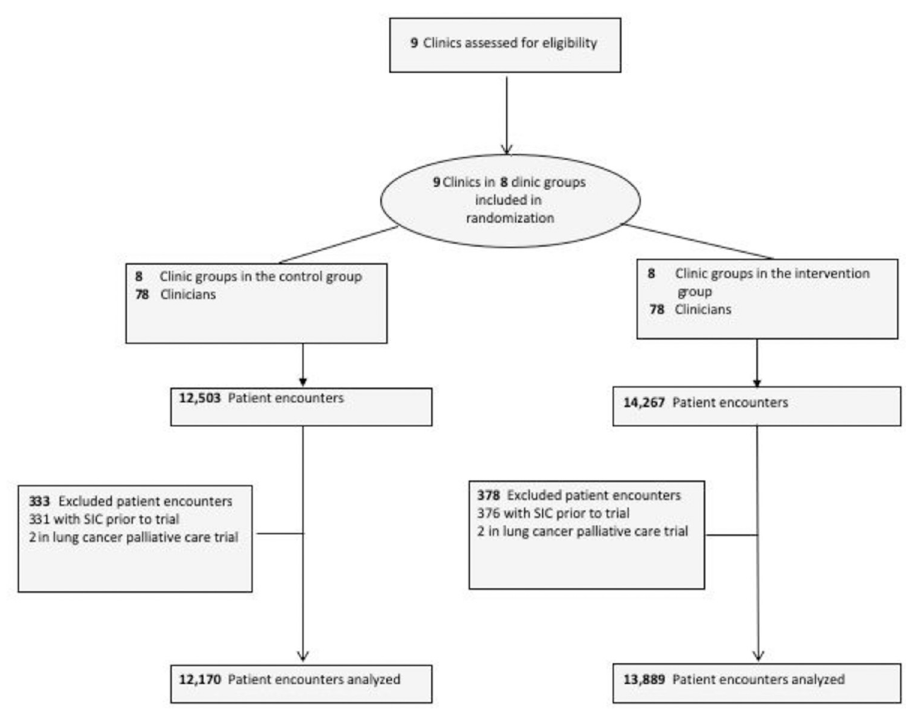
Fig 1. CONSORT diagram. SIC indicates serious illness conversation, a type of